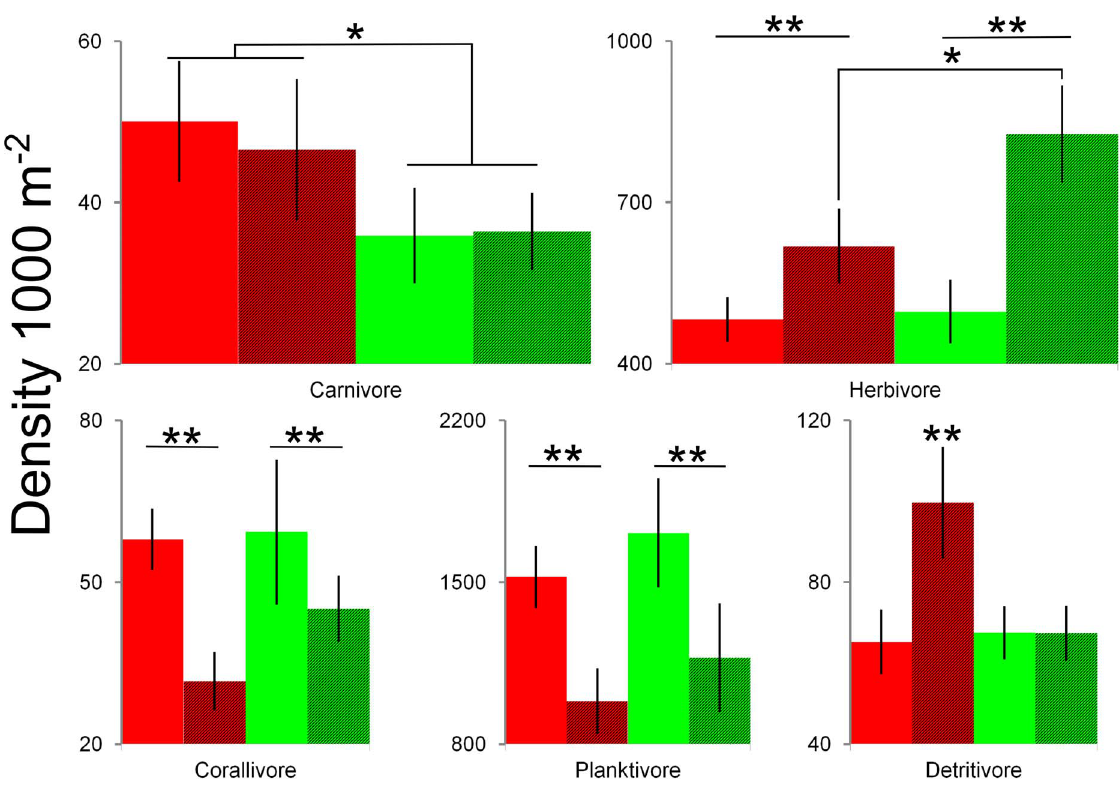
Figure 4. Mean density of trophic groups ( ± 95% confidence intervals) for fished (red) and non-fished (green) reefs. The density of trophic groups across fished, non-fished, disturbed (stippled bars) and non-disturbed (solid bars) reefs are shown. ** p , 0.01 and * p , 0.05 for permuted ANOVAs and permuted t -tests.